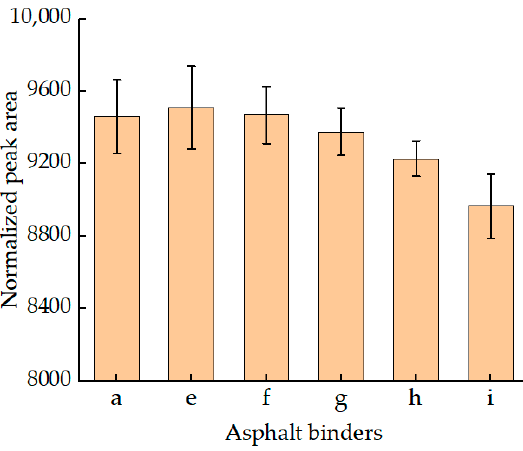
Figure 7. The NPA of CRM asphalt binders unaged.